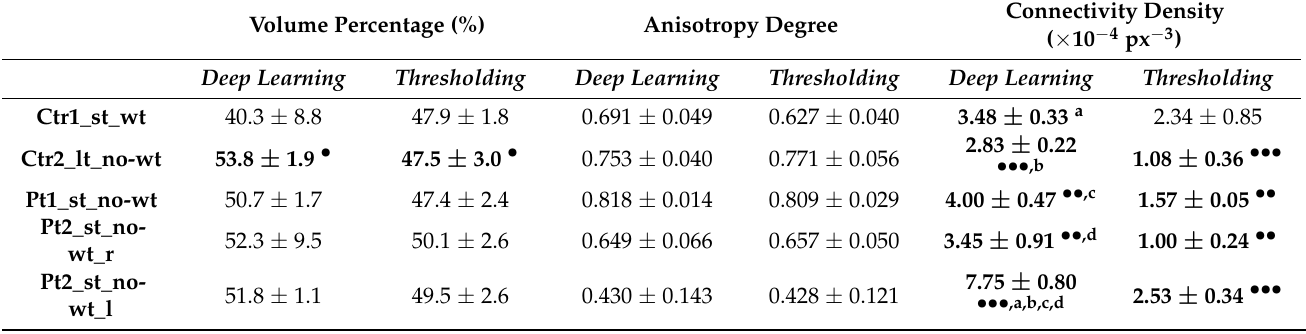
Figure 4. ( a ) Raw slice of a Ctr1_st_wt subvolume, as achieved after phase-retrieval reconstruction; ( b ) semantic segmentation of the same slice with deep learning: transversal bundles (yellow), longitudinal bundles (blue) and background (teal) were detected. ( c ) Application of artificial intelligence to a Ctr2_lt_no-wt subvolume and automatic segmentation of collagen bundles (blue: longitudinal; yellow: transversal). Table 3. Welch t -test between deep learning vs. thresholding segmentation; Brown–Forsythe and Welch ANOVA test, Dunnett’s multiple comparisons between samples per parameter (only